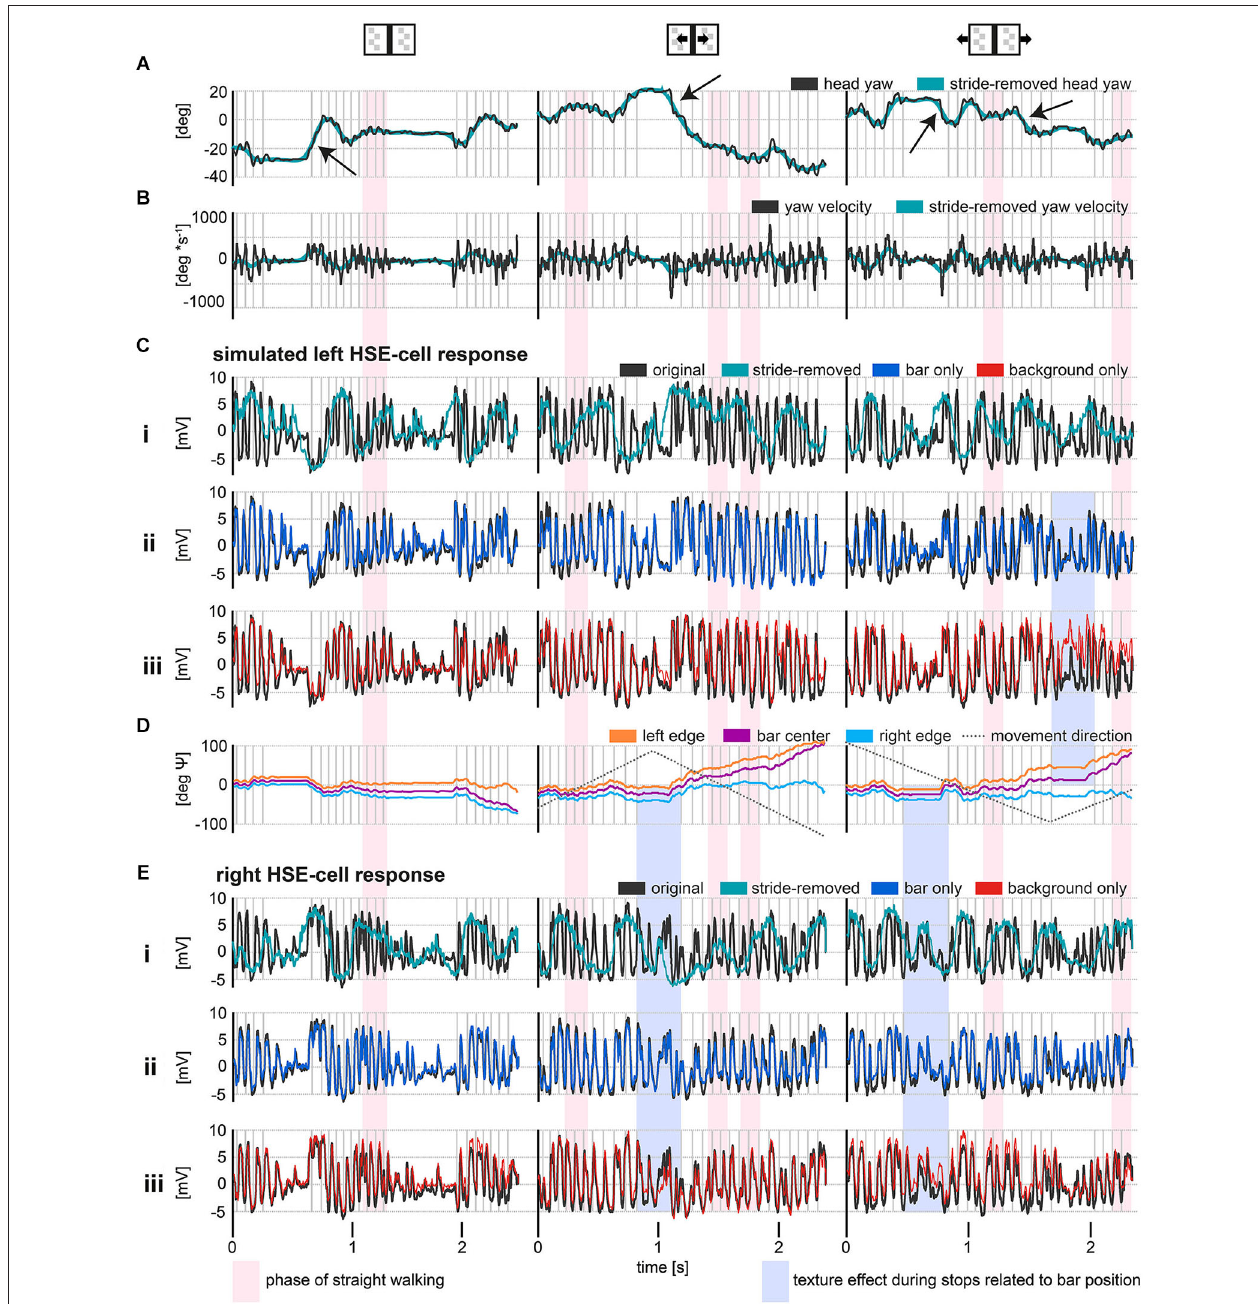
of the yaw orientations depicted in (A) . Positive values represent leftward turning velocities while negative values symbolize turning velocities to the right. Exemplary yaw saccades are indicated by black arrows. (C) Average responses of left HSE-cells (resting potential subtracted) to behaviorally generated optic flow. Note that left HSE responses are approximated by recording from right HSE cells stimulated with mirror-symmetrical movies. In the upper row, responses to the original and stride-removed stimulus movies under the respective visual condition are shown. The lower row illustrates responses to original movies and to movies with modified texture properties. (D) Azimuthal position of the bar relative to the head yaw orientation of the fly. The dotted lines represent the motion direction of the bar or background ( Continued